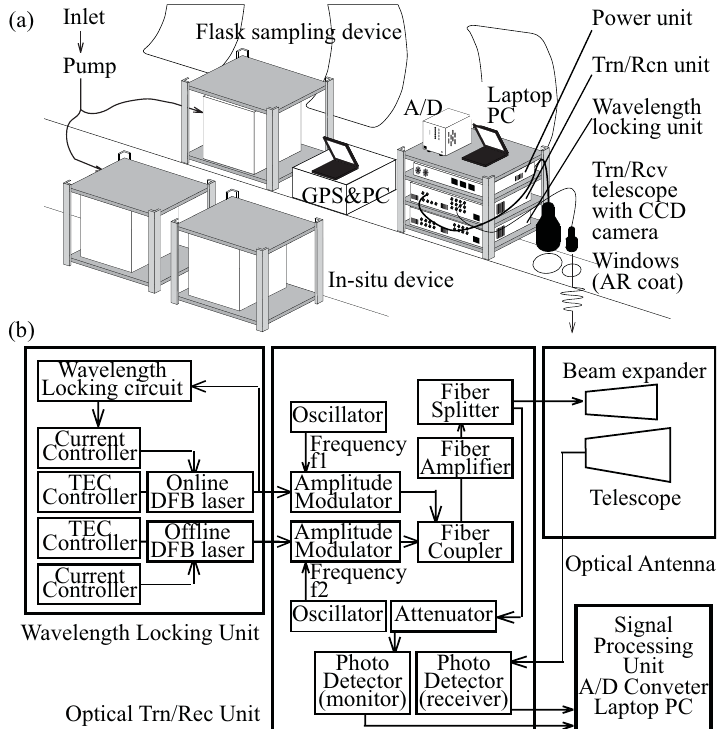
Fig. 2. (a) Airborne instrument setup and (b) block diagram of the 1.57µm prototype LAS system. TEC: thermoelectric cooler, DFB laser: distributed feedback laser. Trn/Rcv: